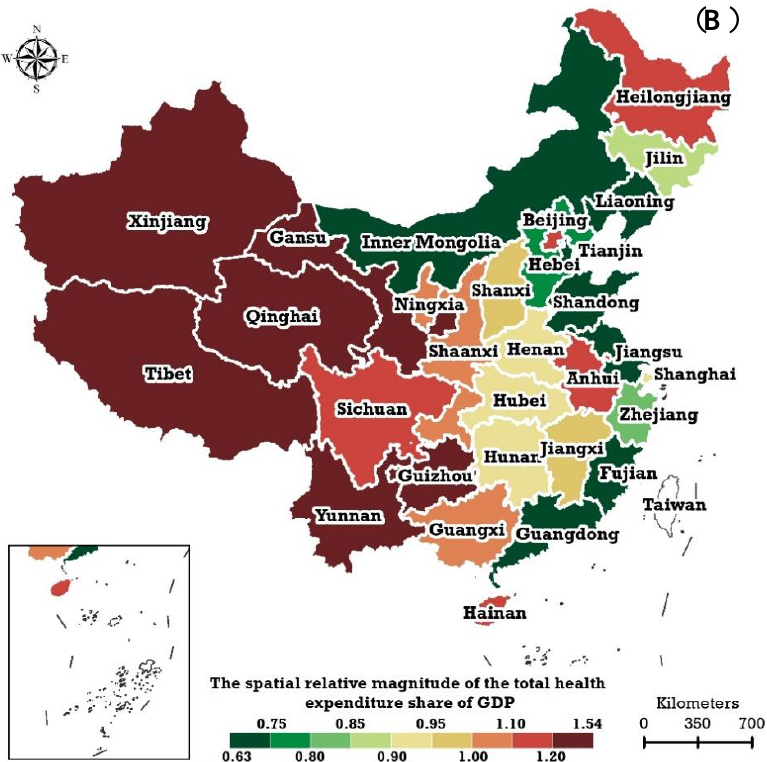
Figure 6. Spatial relative magnitude of ( A ) total health expenditure per capita and ( B ) total health expenditure as a share of GDP in China, estimated by the Bayesian spatiotemporal hierarchy model.